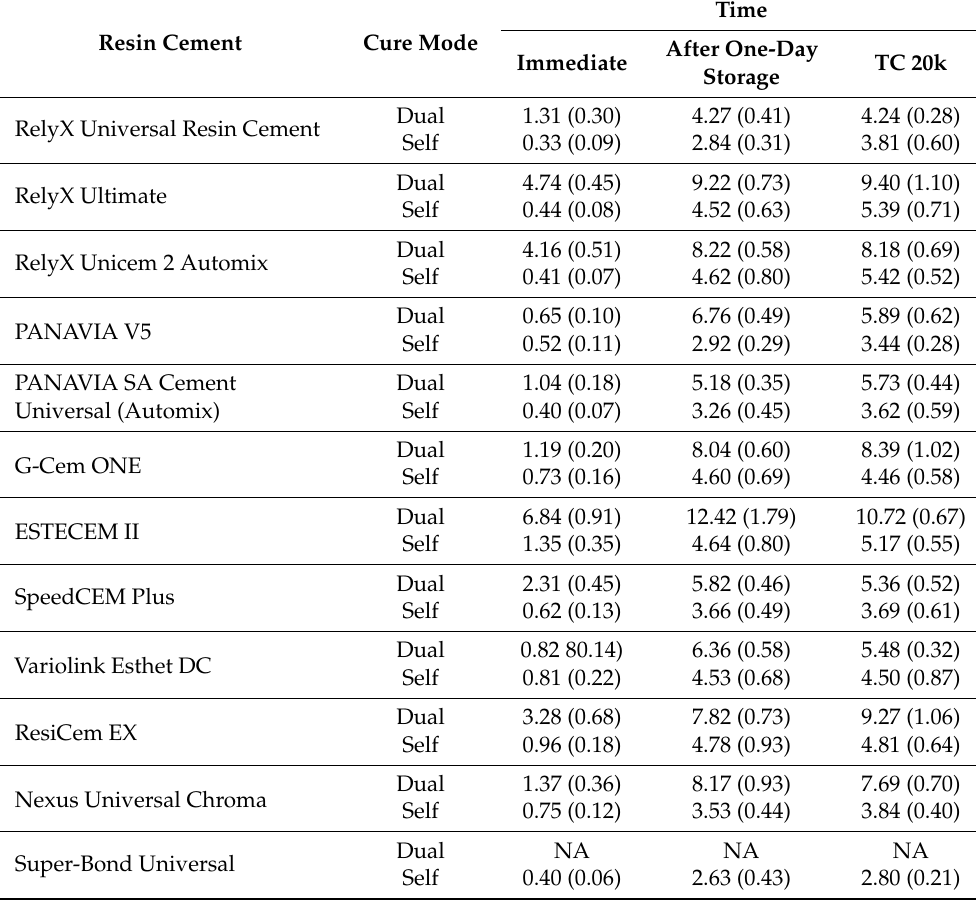
Table 11. Flexural modulus of resin cements [GPa, mean (S.D.)].